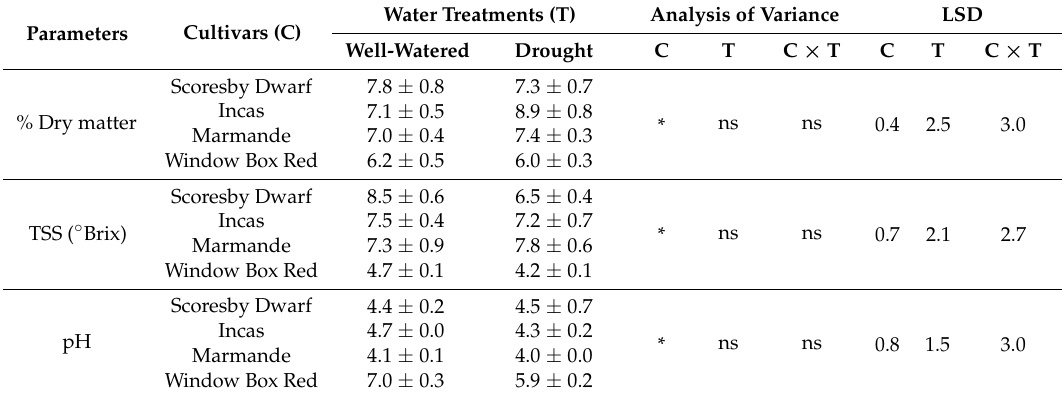
Table 1. Chemical characteristics of four cultivars grown under well-watered and drought conditions.